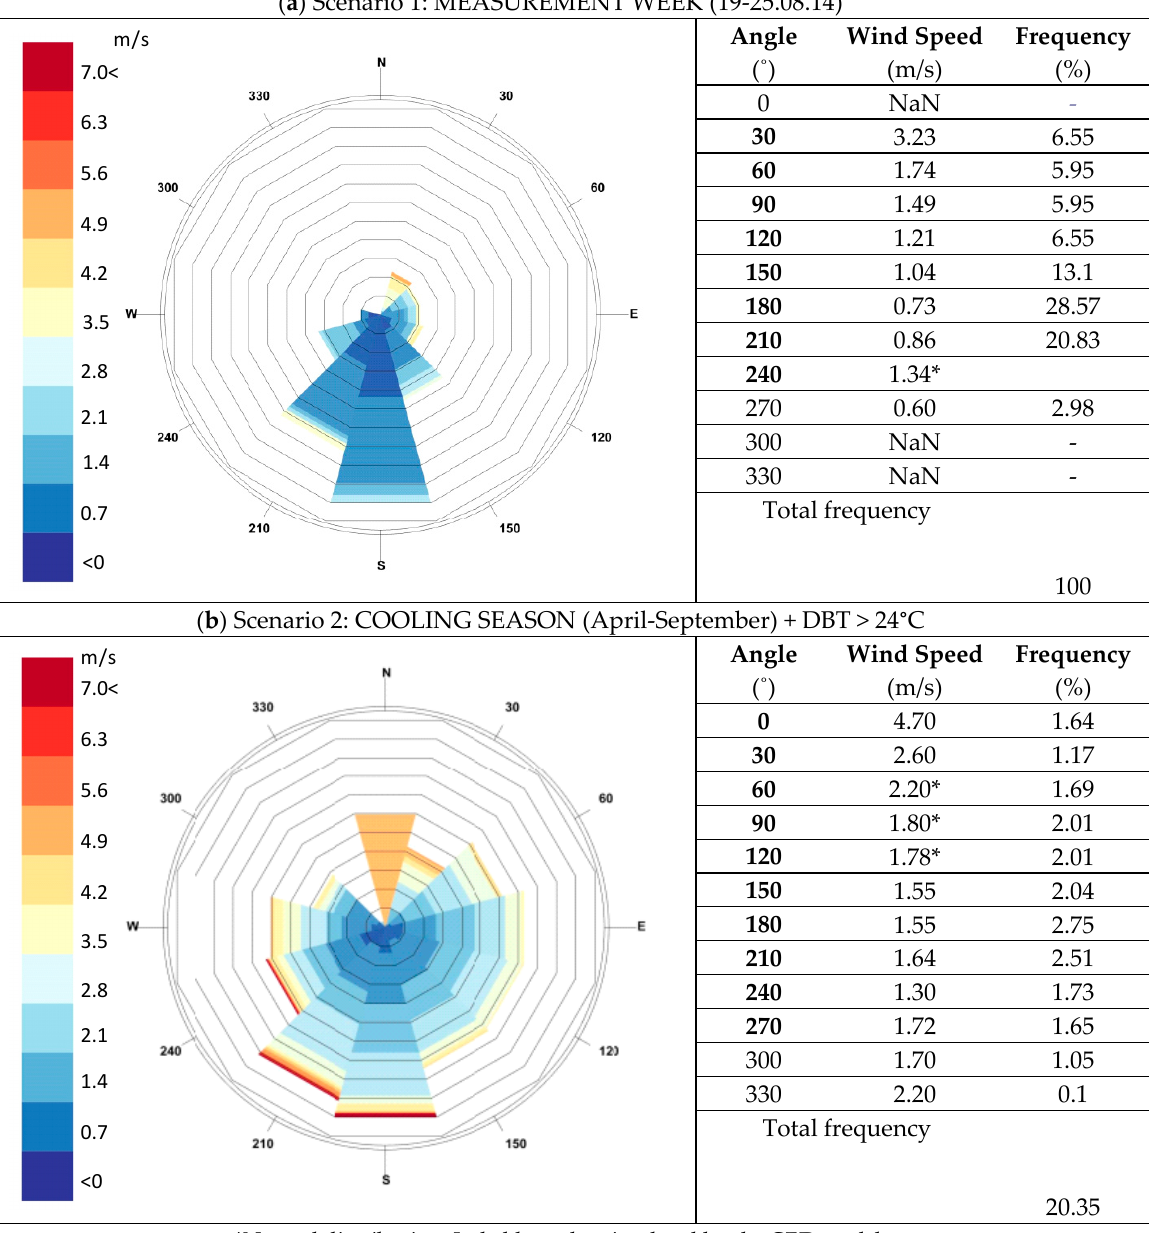
Figure 4. Wind rose, frequency of time, and wind speed by direction. ( a ) Measurement week; ( b ) Cooling season.